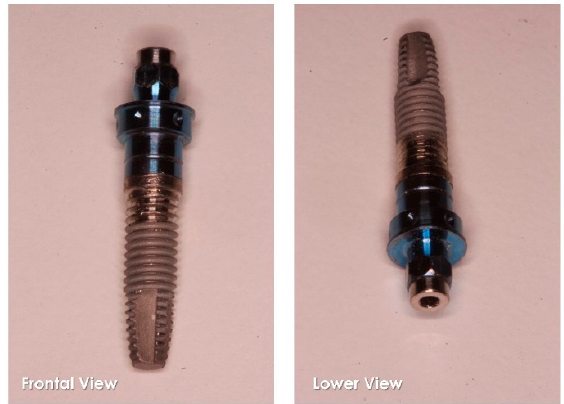
Figure 2. Restore (Keystone Dental, Burlington MA-USA) Control Implant.